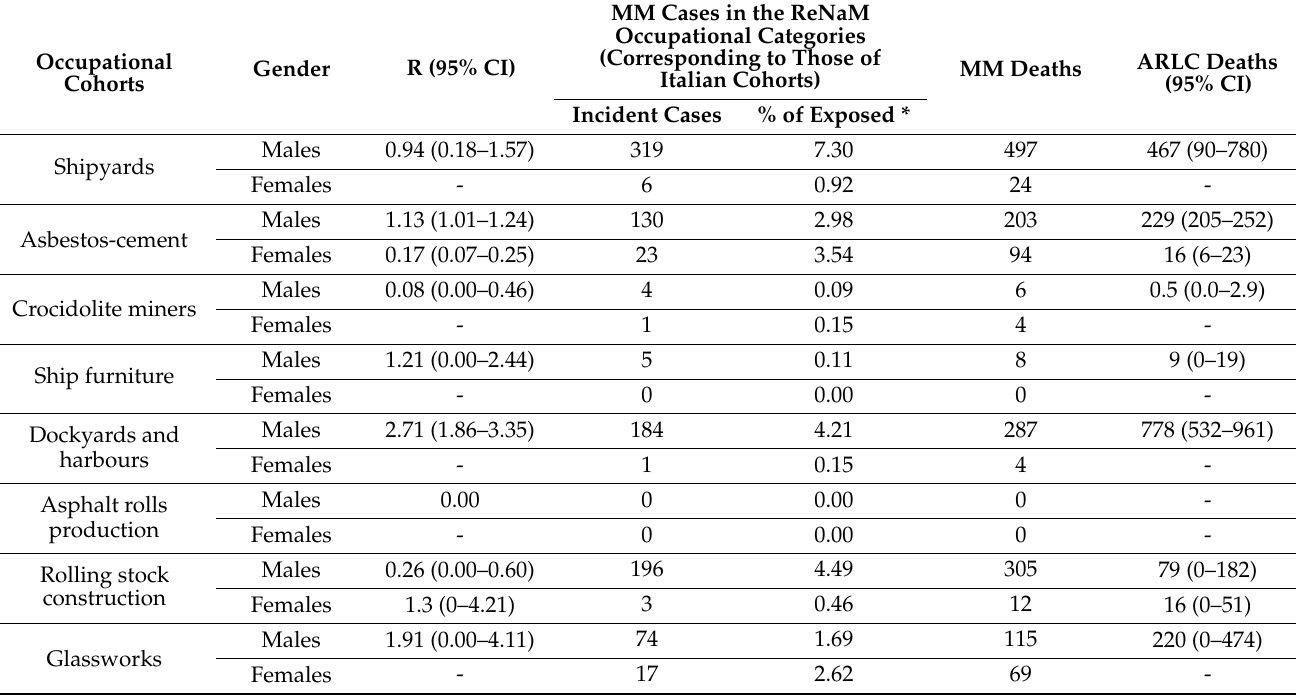
Table 2. Asbestos-related lung cancer (ARLC) and malignant mesothelioma (MM) deaths estimated in occupational categories, by gender. Period: